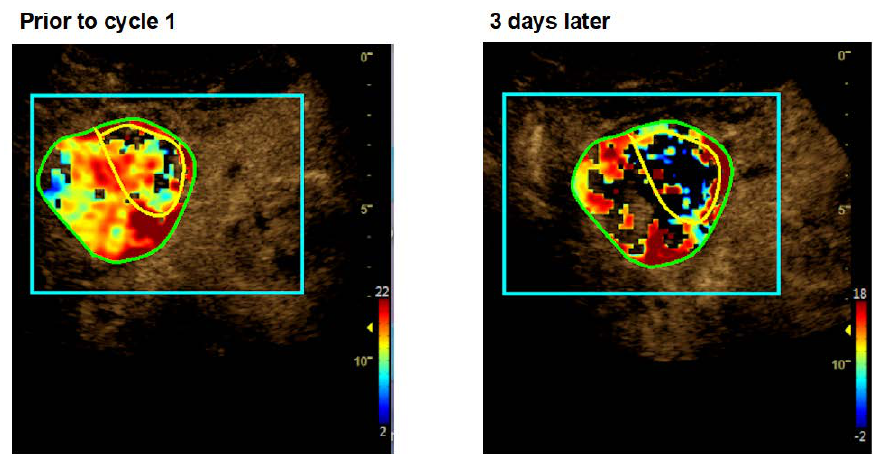
Figure 3. Heat maps of dynamic CEUS in a liver metastasis lesion of a colon adenocarcinoma (UPN 023) before and after 3 days of tTF-NGR (cycle 1). Left part : Before treatment with tTF-NGR at 3.0 mg / m 2 . Right part : Decrease of contrast perfusion after 3 days of 3 mg / m 2 tTF-NGR. Color scales at the right lower corner of each photograph semiquantify contrast perfusion (red = high, blue / black = low). The green circle represents “total lesion”, and the yellow circle represents the “central lesion” (for values, see Supplementary Table S4).